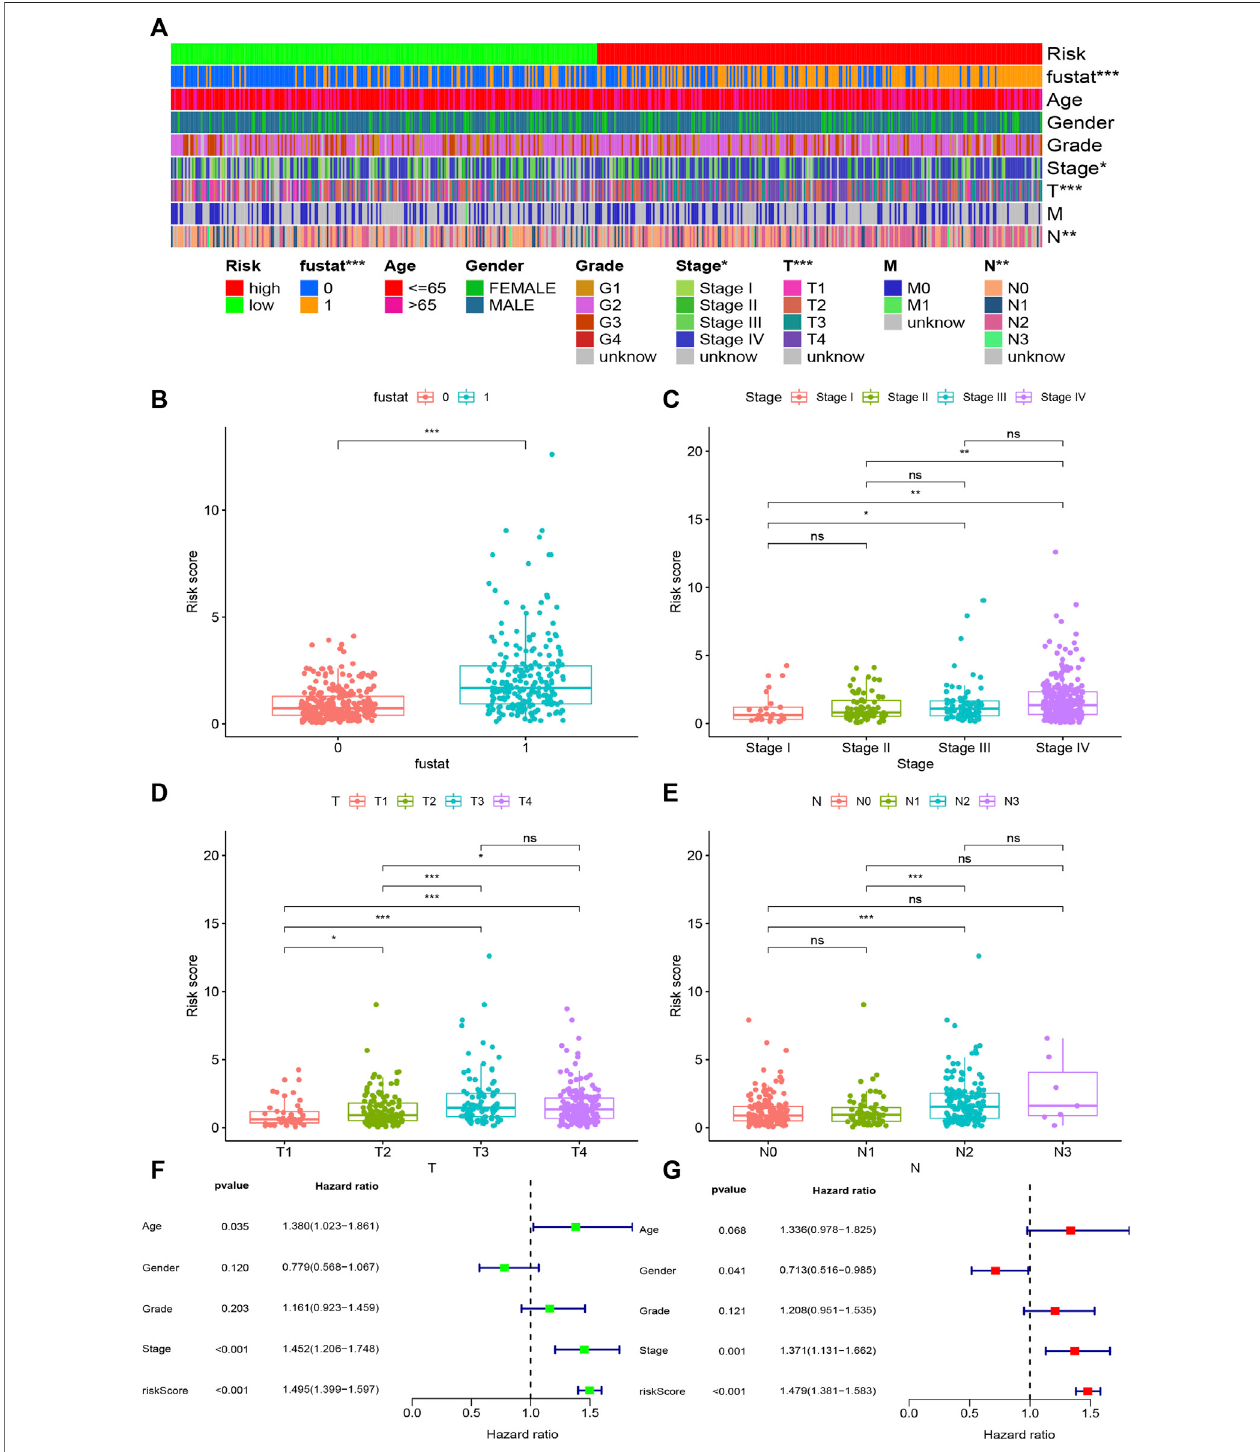
FIGURE4| Evaluation ofclinicalcharacteristicsbytheriskassessmentmodel. (A – E) Astripchartalongwiththescatterdiagramshowsthatsurvivalstatus,clinical stage, T stage, and N stage were signi fi cantly associated with the risk score. (F, G) Univariate Cox regression analysis shows that the risk score, age, and clinical stage werestatisticallydifferent,whilethecorrespondingmultivariateCoxregressionanalysisshowsthatonlytheriskscoreandclinicalstagewereindependentprognosticrisk factors.